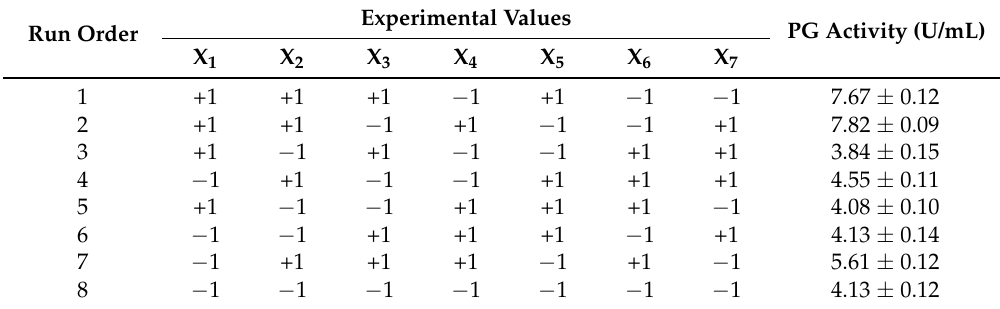
Table 2. Plackett-Burman design (PBD) of variables (in coded levels) with polygalacturonase (PG) activity as